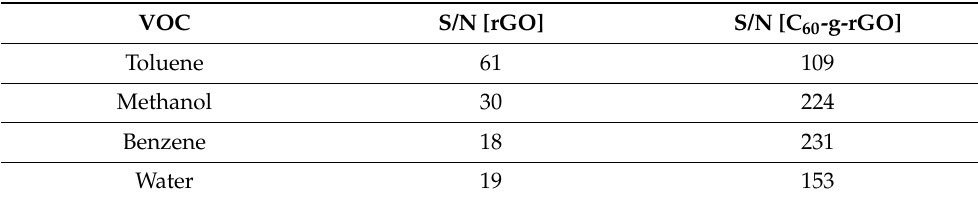
Table 3. Signal-to-noise (S/N) ratio of rGO and C 60 -g-rGO sensors towards four selected VOC at 400·ppb